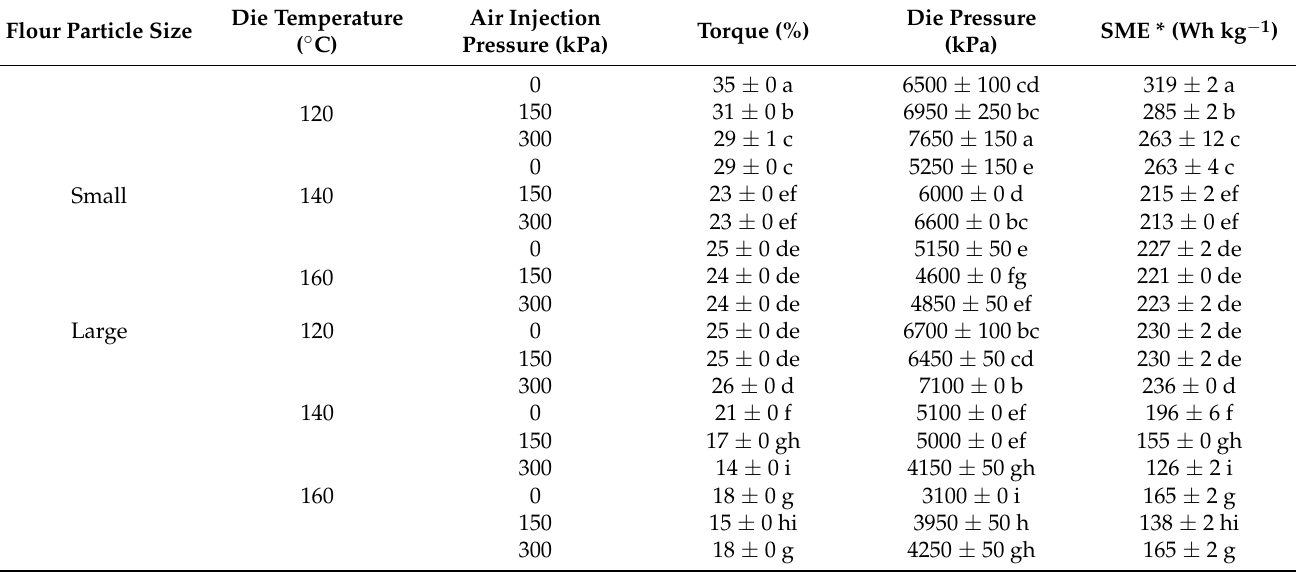
Table 1. Experimental design and dependent extrusion process variables.